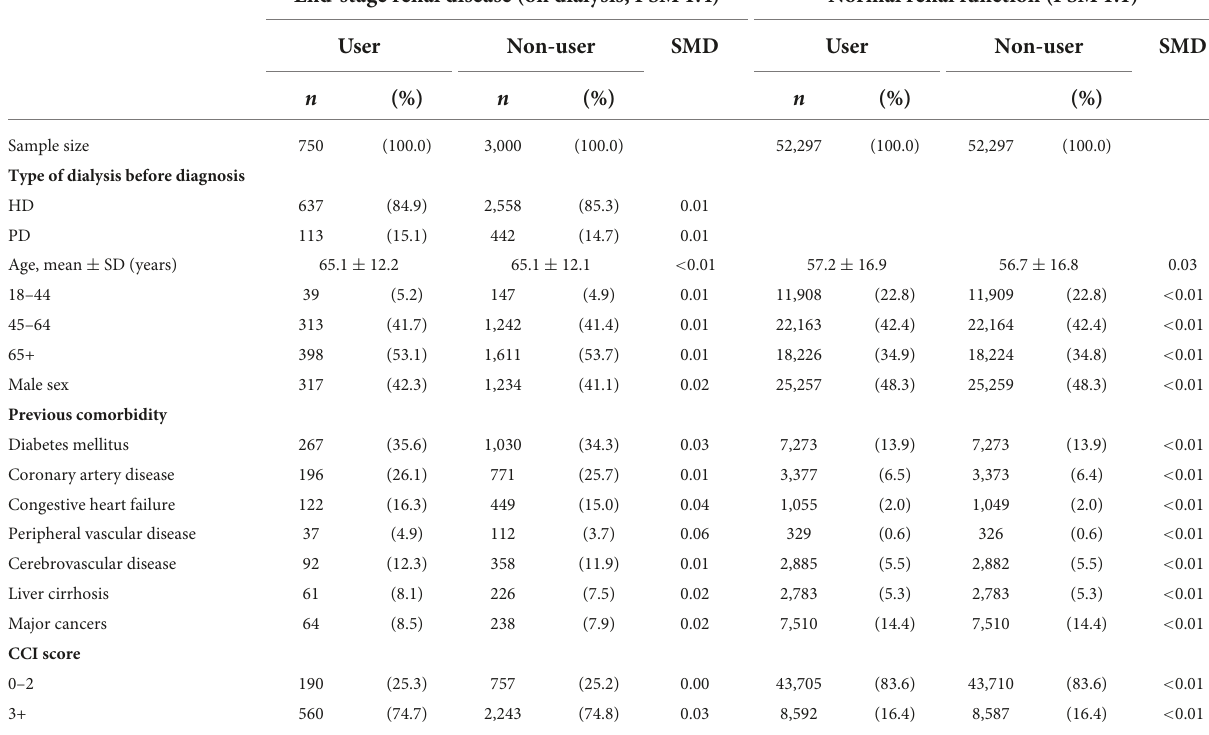
TABLE 1 Baseline characteristics of patients with herpes zoster receiving or not receiving valacyclovir after propensity score matching. End-stage renal disease (on dialysis; PSM 1:4) Normal renal function (PSM